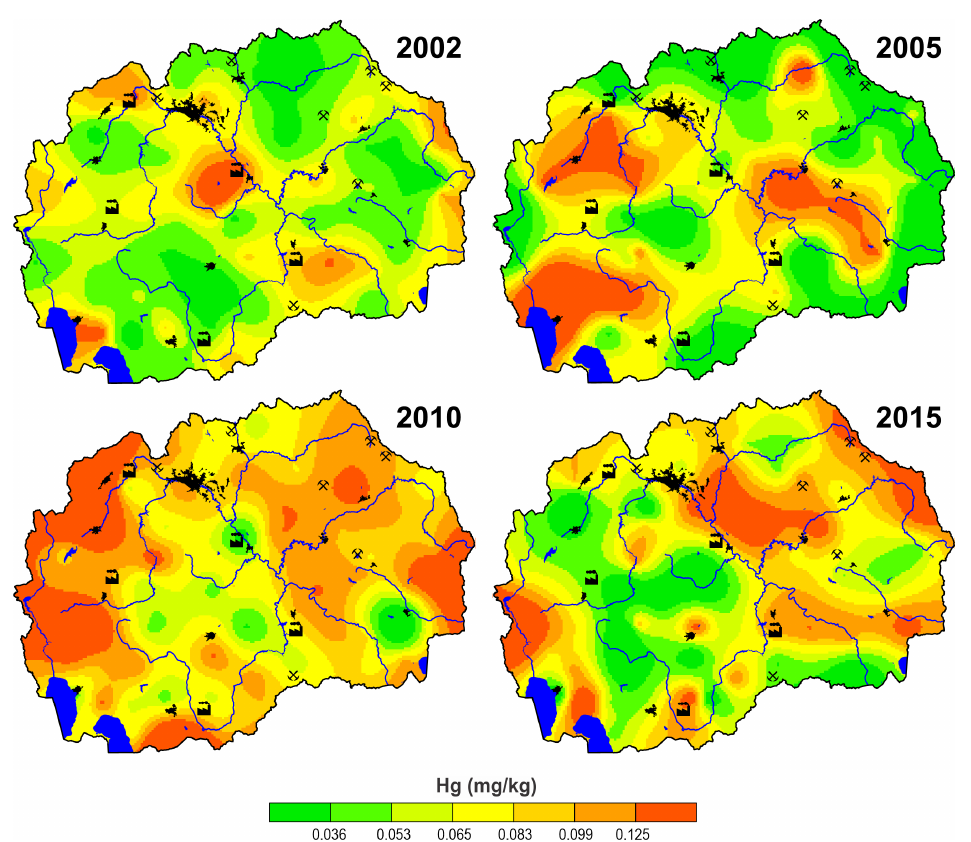
Figure 4. Distribution of Hg in moss samples collected in 2002, 2005, 2010 and 2015.